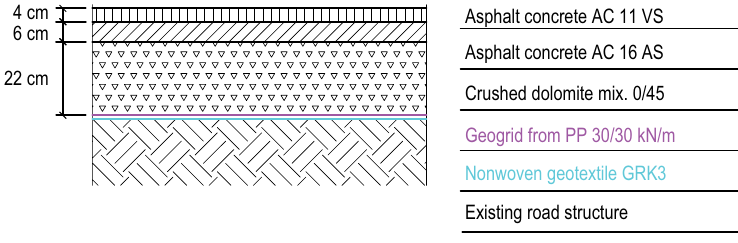
Figure 1. Road structure No.